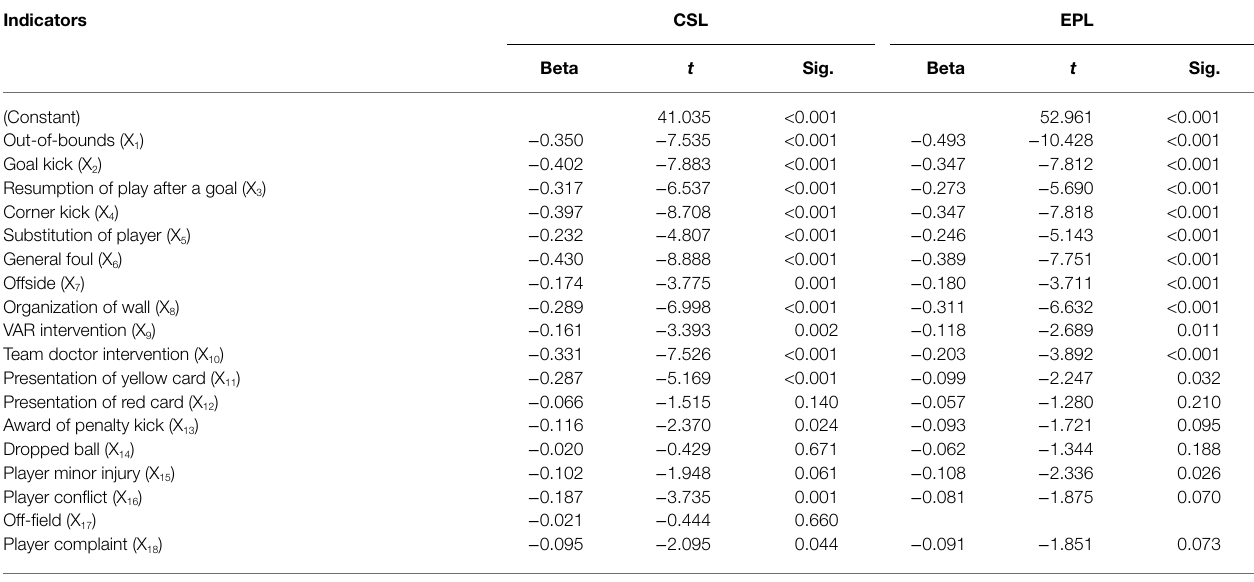
TABLE 4 | Linear regression coefficient for stoppage time and actual playing time.